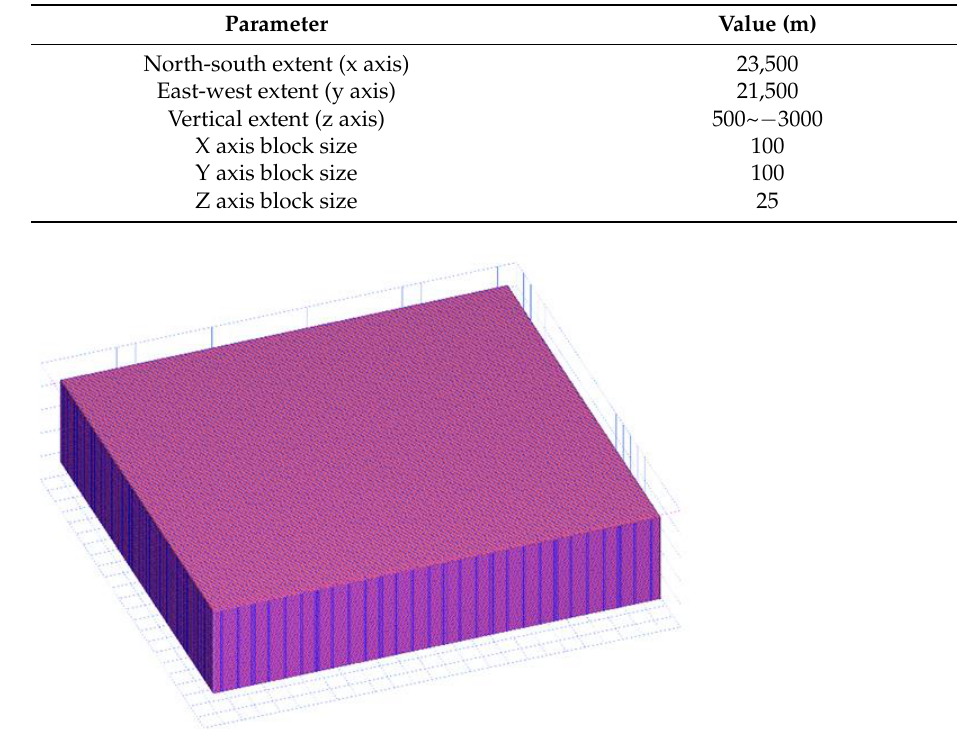
Table 2. Definition of spatial parameters for 3DMPM in Xuancheng–Magushan Area.